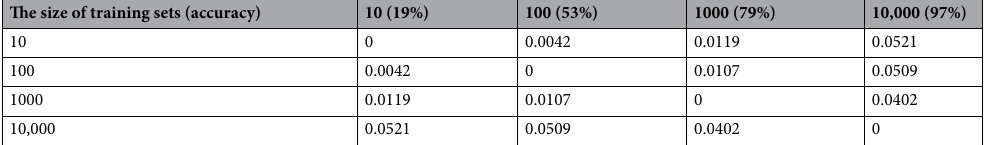
Table 1. The D-values for each pair of neural networks obtained by different sizes of training sets. The number of hidden layers is 30 and training times is 100. Number in parentheses represents the classification accuracy of the corresponding neural network. The larger the training set, the higher the accuracy.